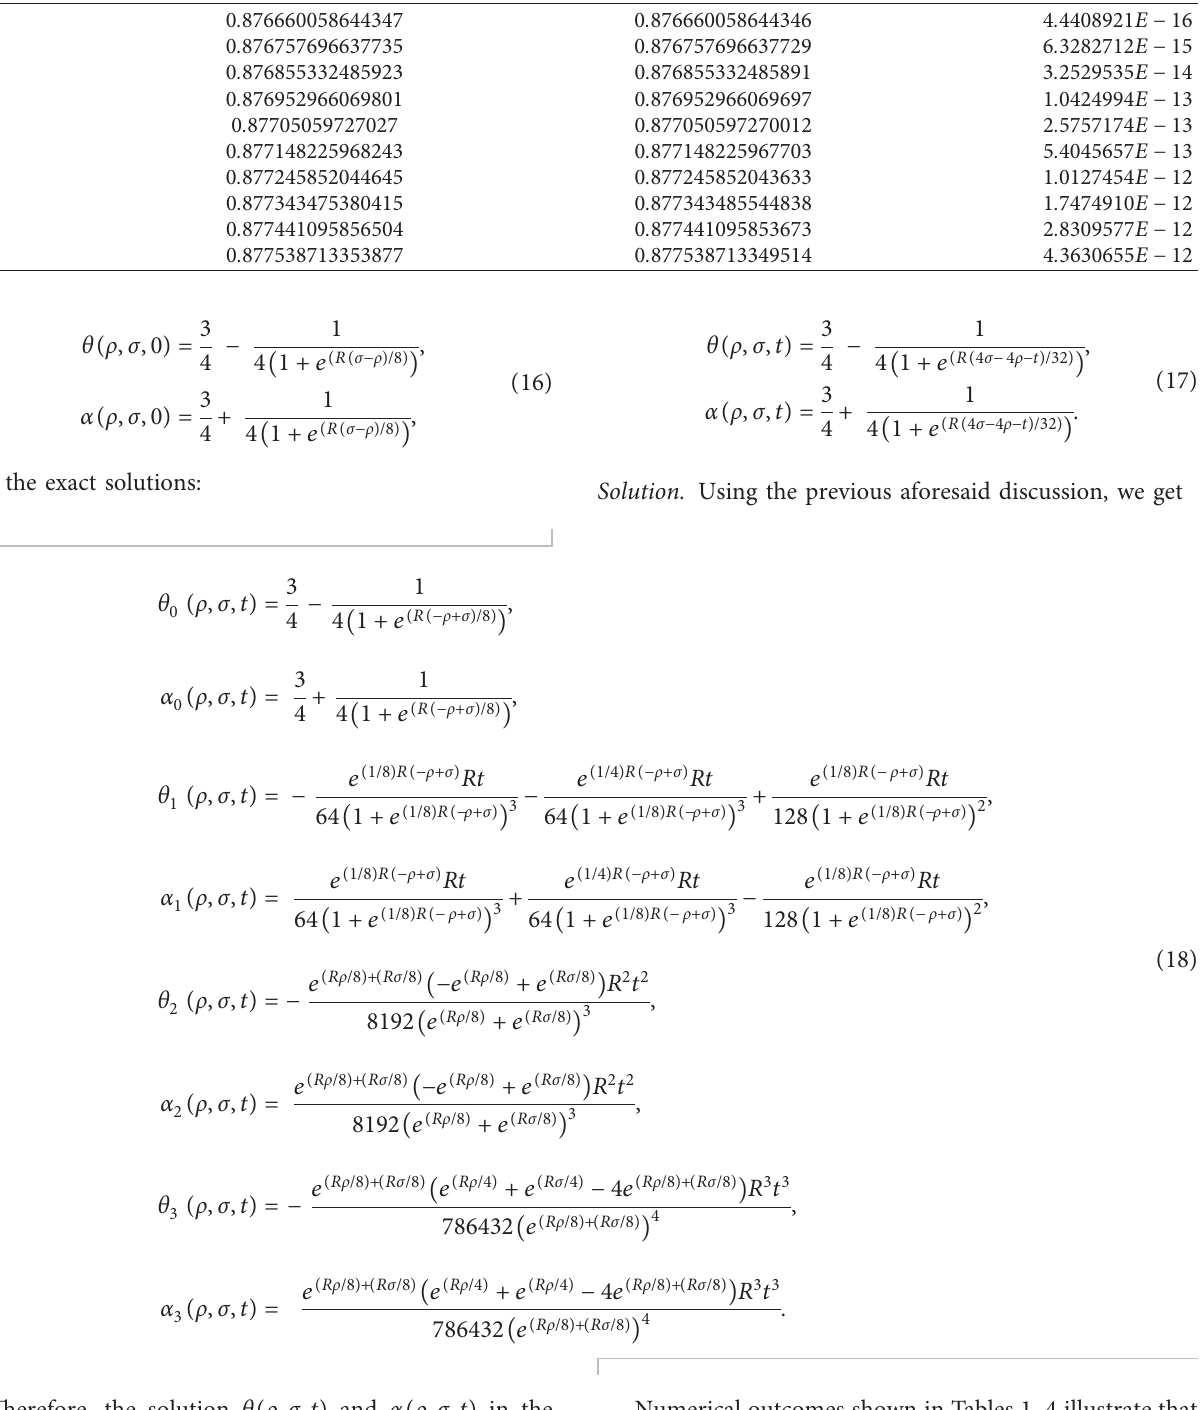
Table 4: The (SDM) results for α ( ρ , σ ,t ) , for first four approximations, and for R � 1, with mesh points ρ � 0.3 and σ � 0.1, for Example 2.